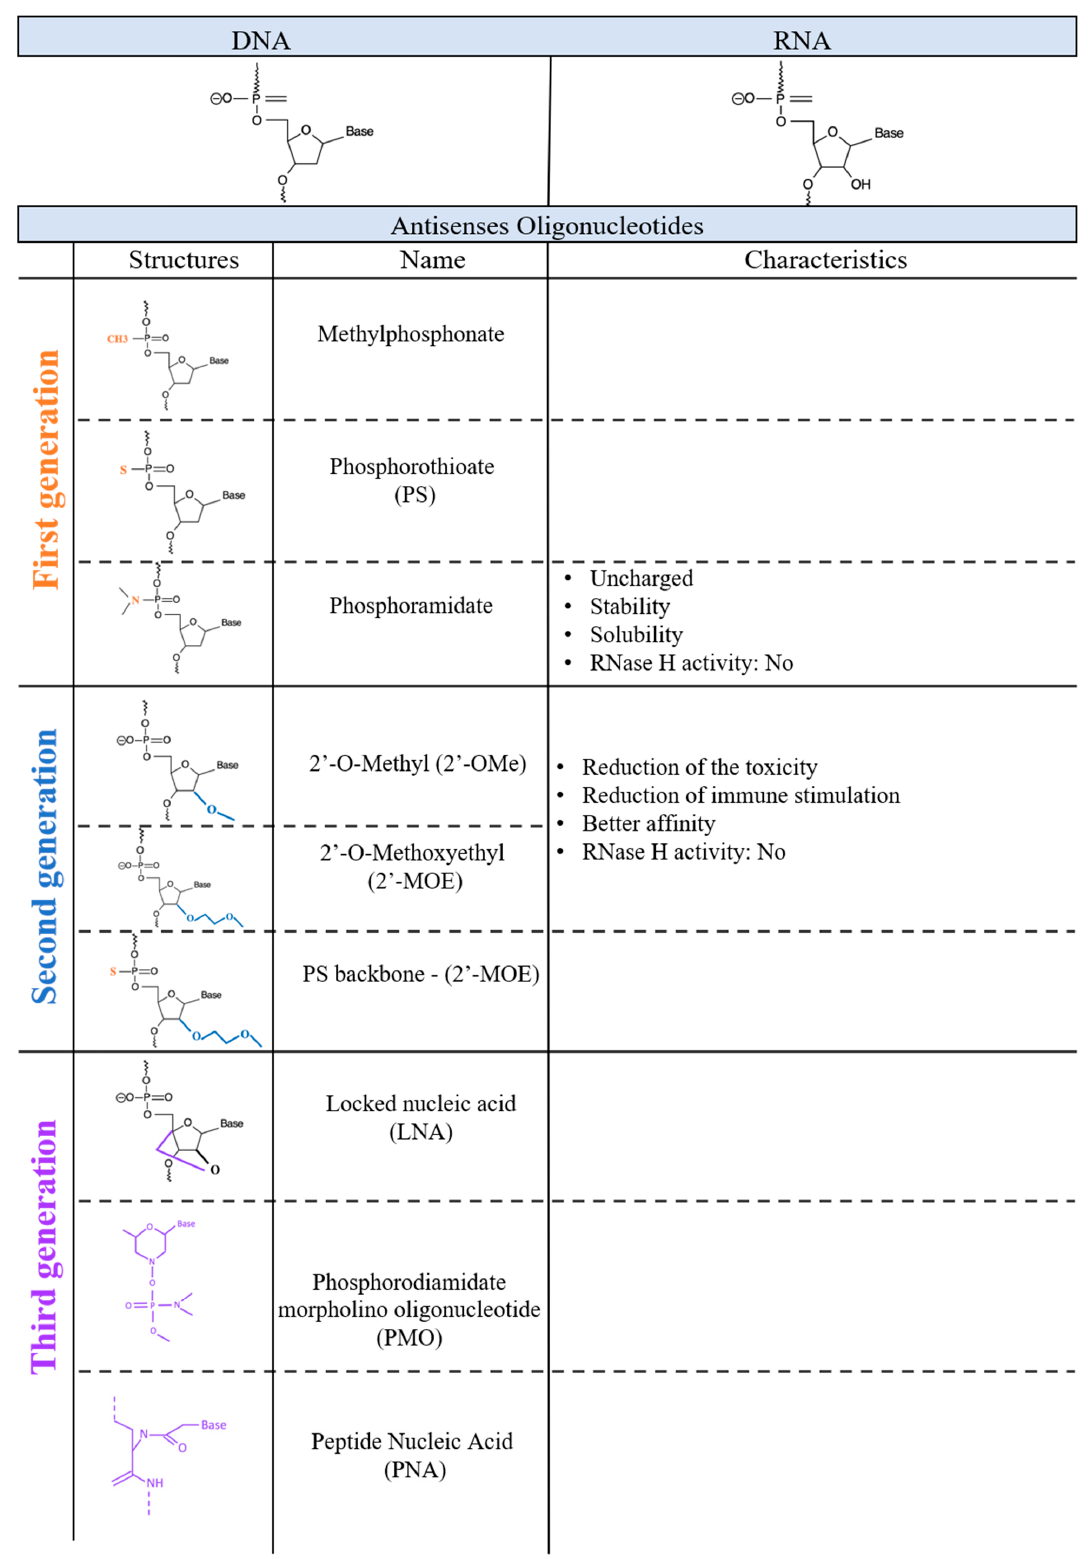
Figure 1. Schematic representation of different chemical characteristics of each generation of ASOs. Main chemical structure and specific characteristics for each compound described in the text are